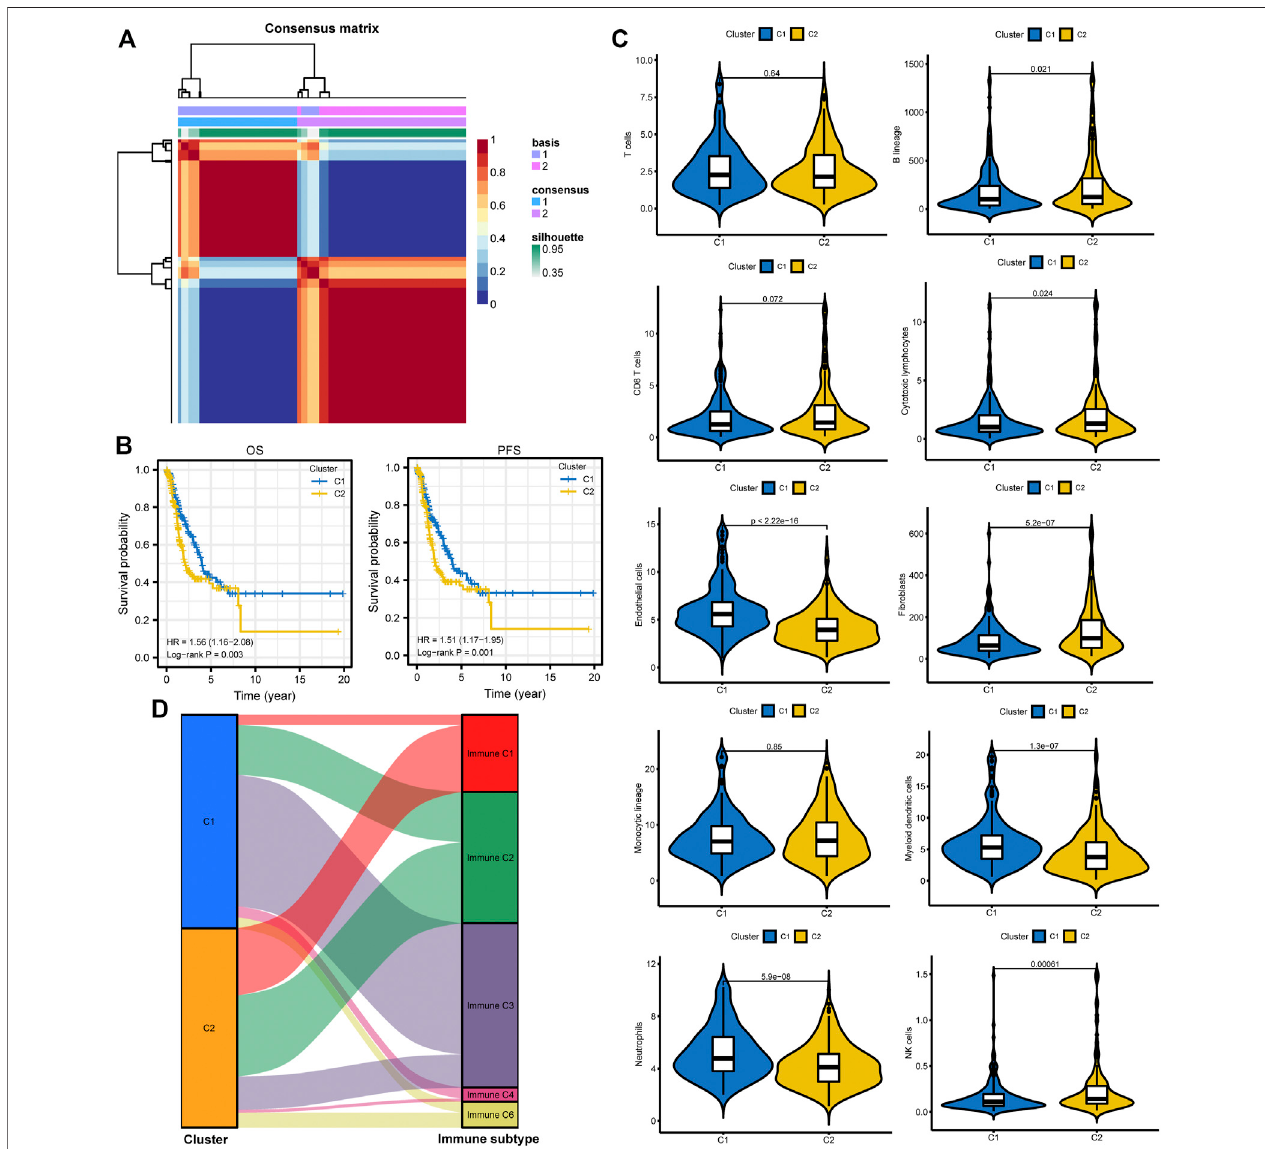
FIGURE 4 | Different subtype identi fi cation and clinical relevance analysis. (A) Two different subtypes were identi fi ed via the NMF algorithm. (B,C) The relationship between different subtypes and OS and PFS of LUAD. (D) TME composition between different subtypes. (E) Sankey plot to show the association between different subtypesandimmunesubtypes. NMF,non-negativeMatrixFactorization;OS,overallsurvival;PFS,progression-freesurvival;LUAD,lungadenocarcinoma;TME,tumor